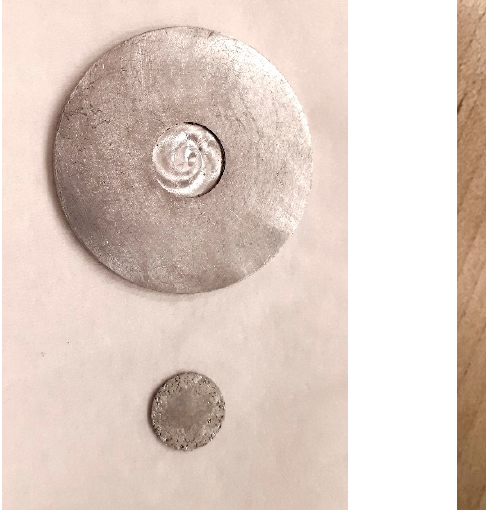
Table 1. Natural abundance of zinc isotopes [9] and produced gallium isotopes. Half-lives from [10]. Zn isotopes 64 Zn Ga isotope